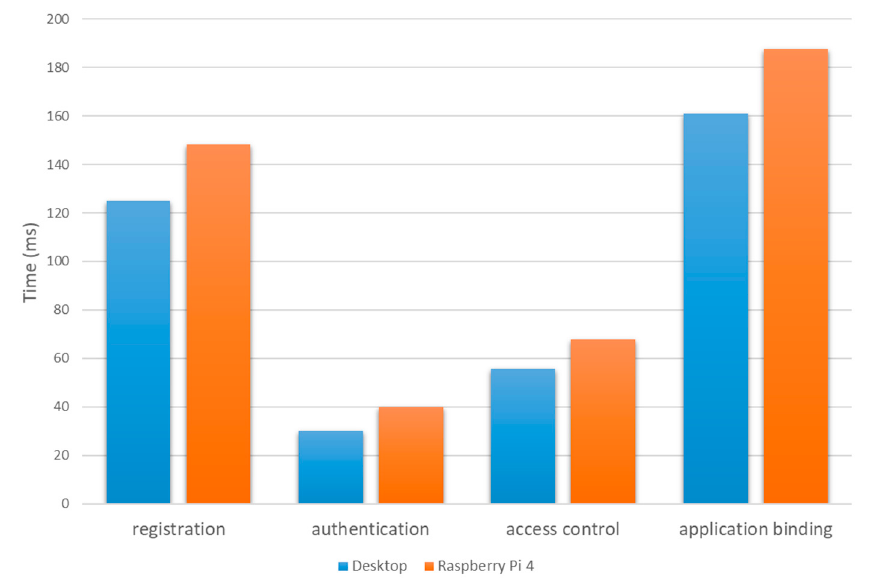
Figure 10. Statistics of average time consumption of platform key processes.